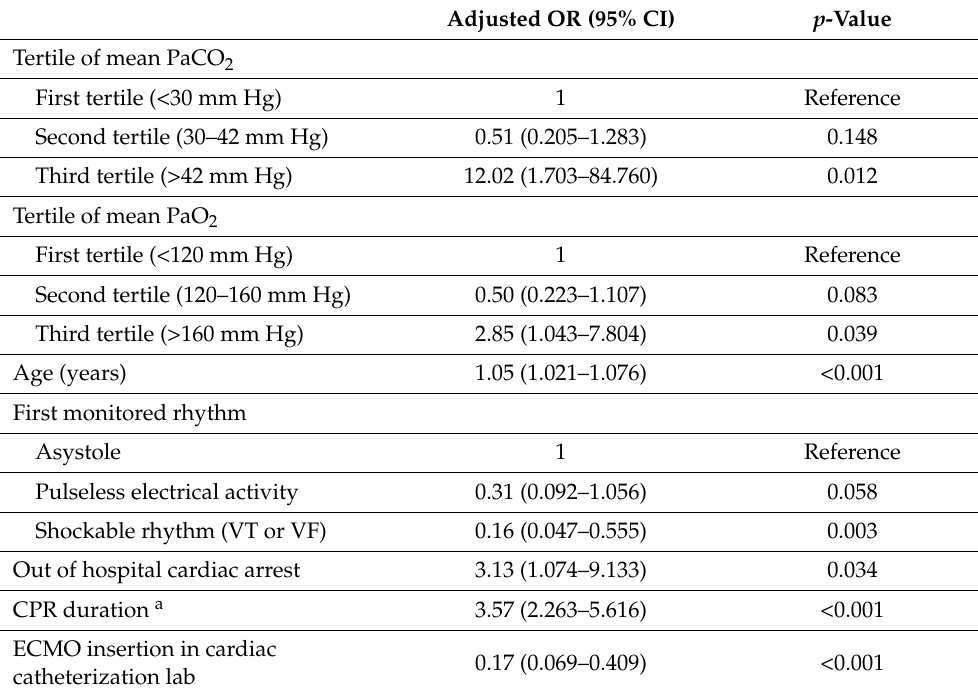
Table 3. Multivariable analysis of factors associated with poor neurological